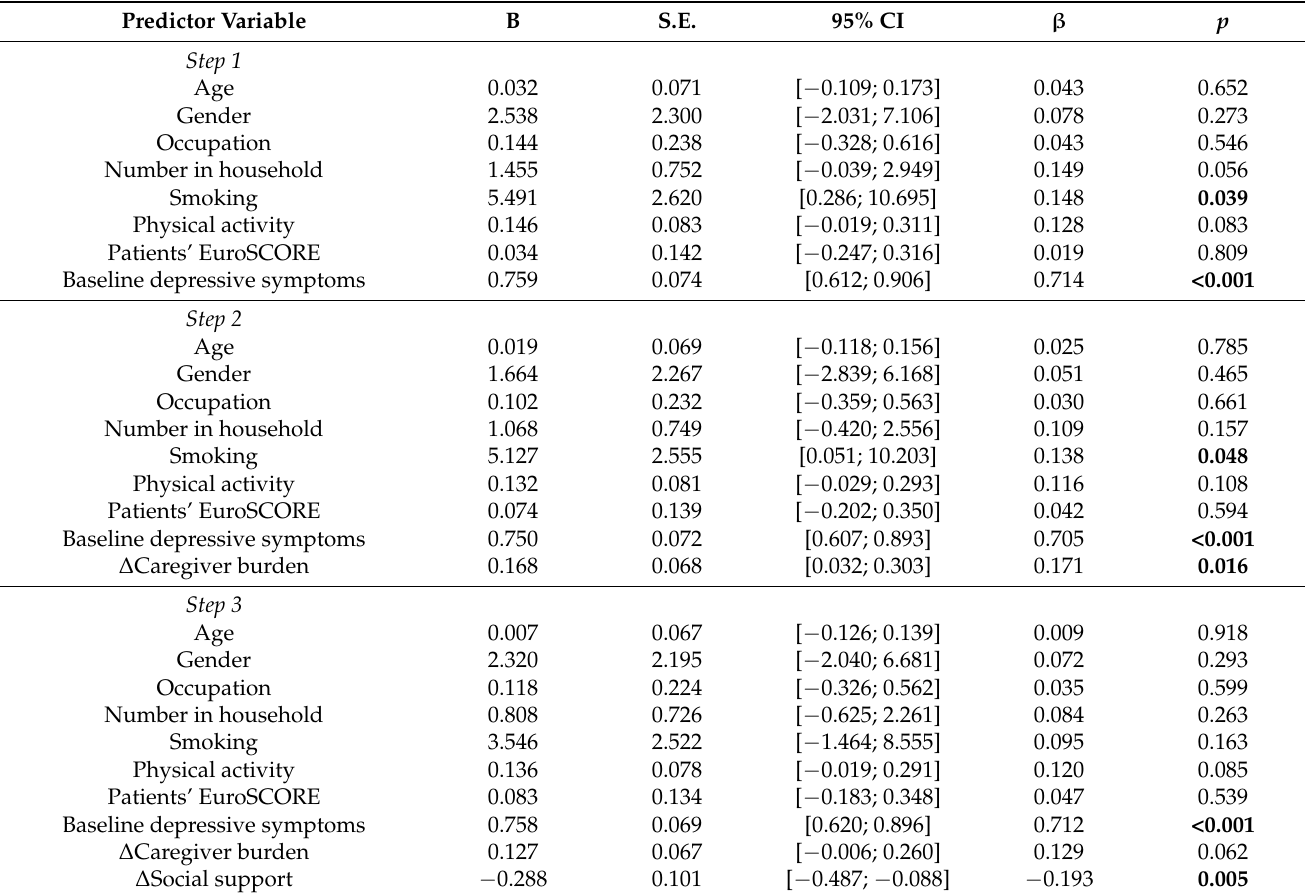
ining the direct and total effects in the relationship between ∆ caregiver burden (i.e., the change from pre to post surgery) and depressive symptoms at the 2-month post-surgery follow-up, adjusting for covariates. Step 2 of the model shows the direct effect; a greater increase in caregiver burden was a significant predictor of higher depressive symptoms ( β = 0.171, p = 0.016). Table 4. Hierarchical linear regression of depressive symptoms on caregiver burden and social support (N = 101). Predictor